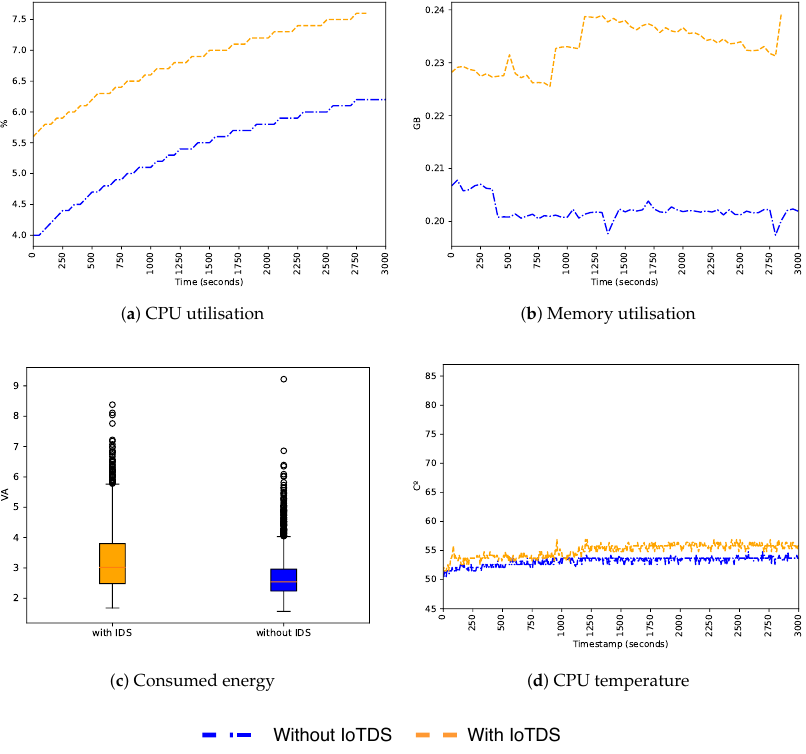
Figure 8. Behaviour of the SC profile regarding host’s resource usage with and without the